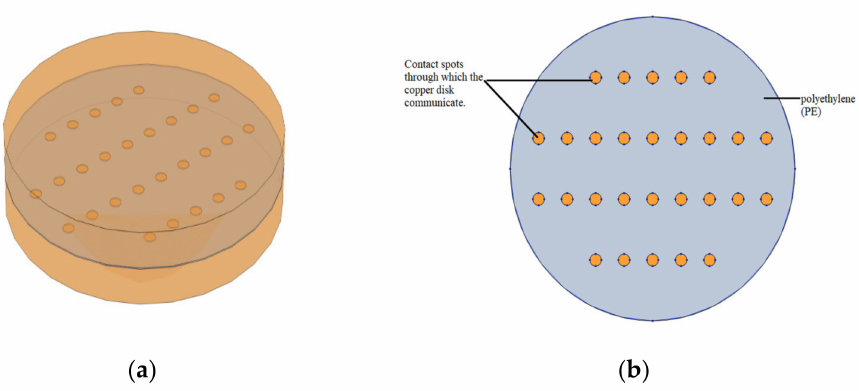
Figure 6. Geometrical model of the problem investigated: ( a ) two copper disks in contact; ( b ) contact spots and the insulating layer of polyethylene (PE) at the